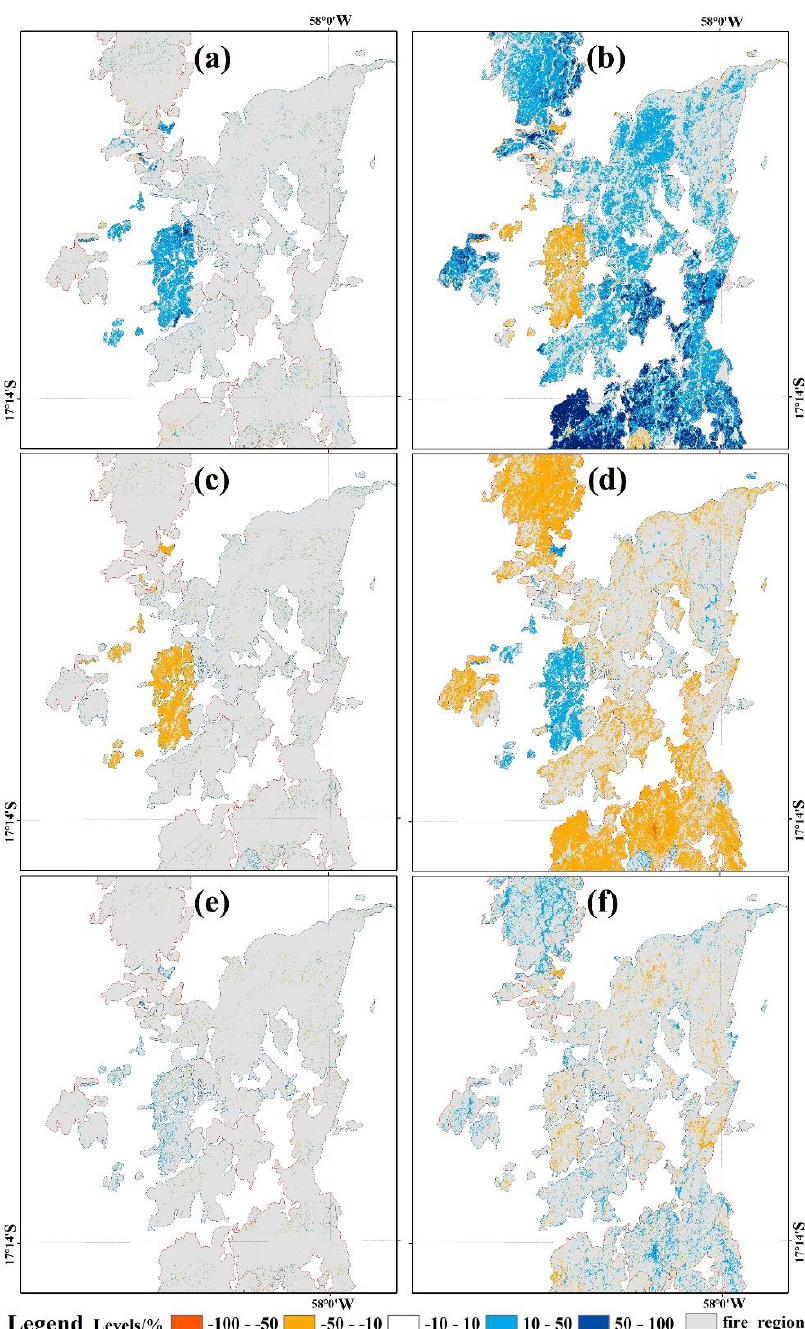
Figure 8. Change detection of the wetland: ( a,c,e ) in August; ( b , d , f ) in September. Note that a, b represents the dynamic rate of MNDWI, c, d represents the dynamic rate of NDVI, and e, f represents the dynamic rate of NDSI.